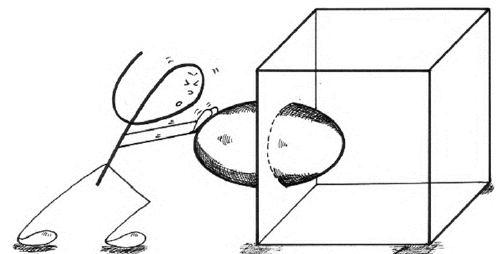
Figure 7. An example of a lattice.